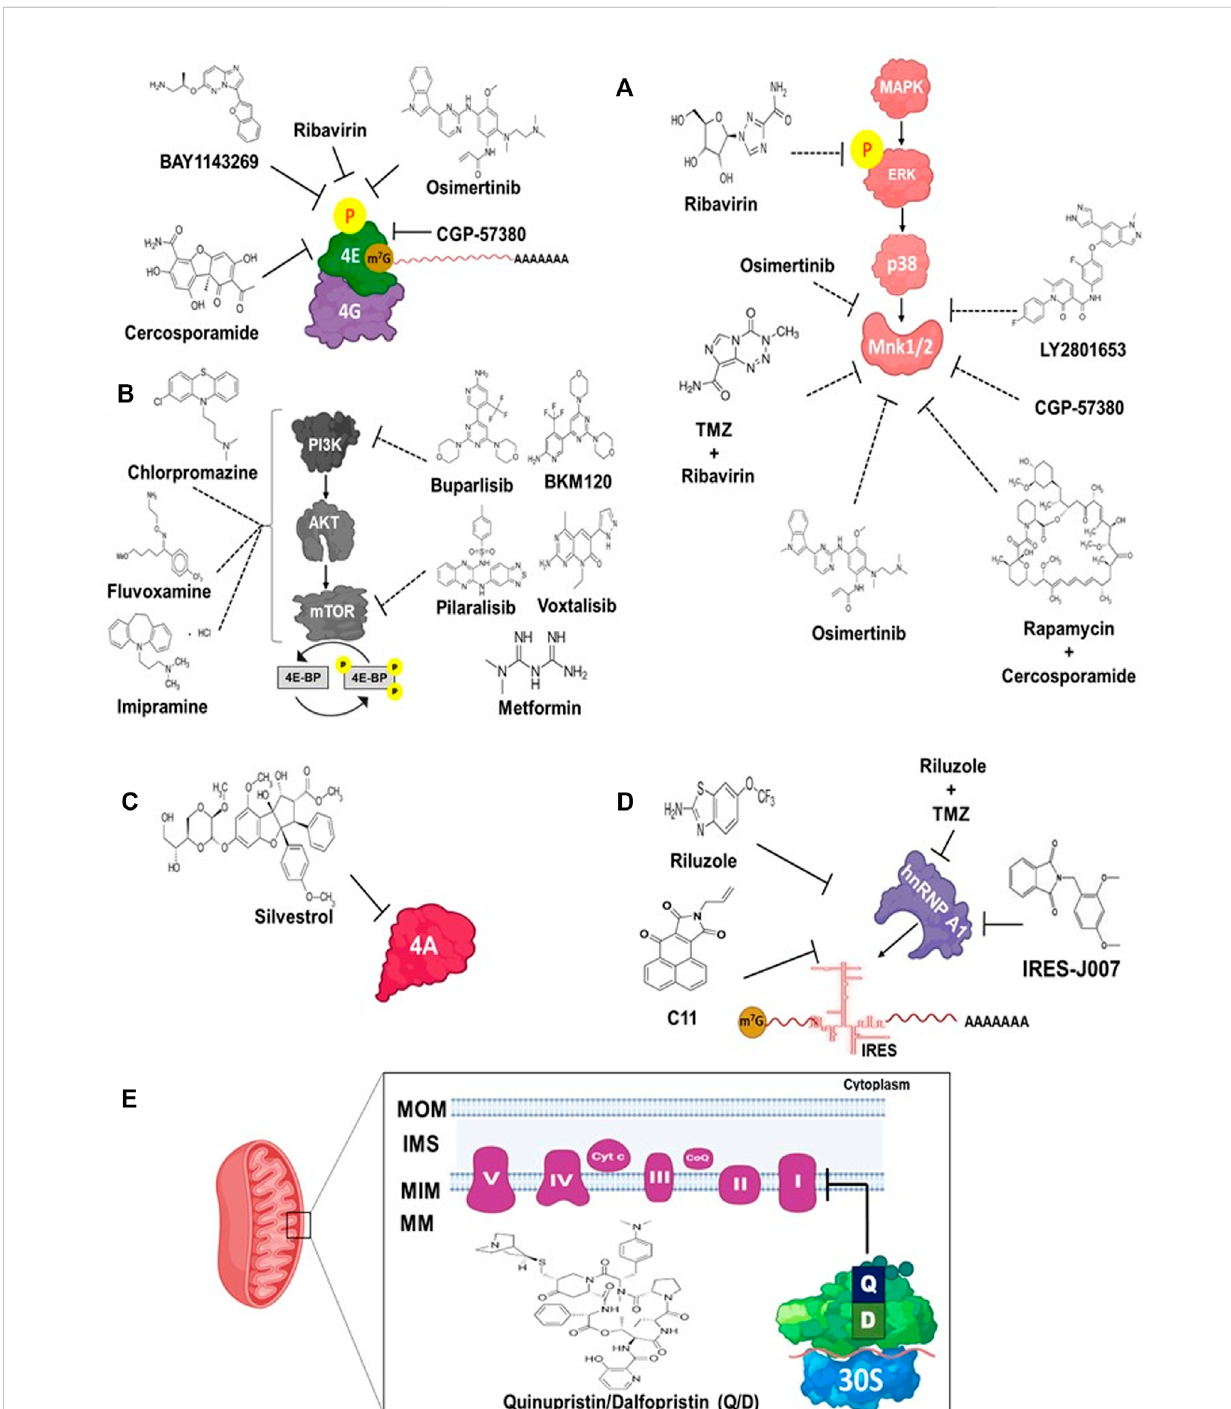
FIGURE 7 ChemicalcompoundstargetingtranslationinGB. (A) DrugstargetingtheeIF4E/eIF4Gcomplex( Left )andtheMAPK/ERK/p38/Mnk1pathway( Right ). (B) Drugs targeting the PI3K/AKT/mTOR pathway. (C) Silvestrol inhibits the eIF4A ( 4A ) activity. (D) Compounds blocking the interaction between the hnRNP A1 protein with the Cyclin D1 and c-Myc IRES, thereby inhibiting IRES-dependent mRNA translation. (E) Quinupristin and Dalfopristin ( Q/D ) act synergistically to inhibit mitochondrial protein synthesis. These drugs bind to the mitoribosomal large subunit ( green ). MOM , mitochondrial outer membrane; IMS , Inter membrane space; MIM , Mitochondrial inner membrane; MM , mitochondrial matrix. Solid lines indicate a direct effect of the inhibitorsonthetranslationmachinery. Dashedlines